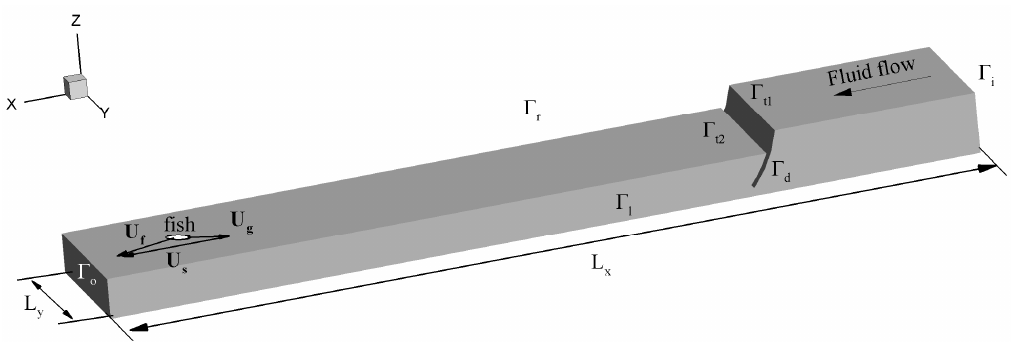
Figure 2. Schematic model structure of a channel. The major surfaces of the computational region are: Γ i , Γ o are the inflow and outflow surfaces; Γ l , Γ r , Γ t 1 , Γ t 2 are left, right and top surfaces; Γ d is the surface of the gate, b is the surface of the bottom (not shown). L x = 63 m,𝐿 (cid:3052) = 11 m, headwater L z 1 = 4.4 m, and tailwater L z 2 = 2.9 m. Vectors U f , U g and U s = U f − U g are fluid velocity, ground velocity of a fish, and swimming speed of the fish, respectively.